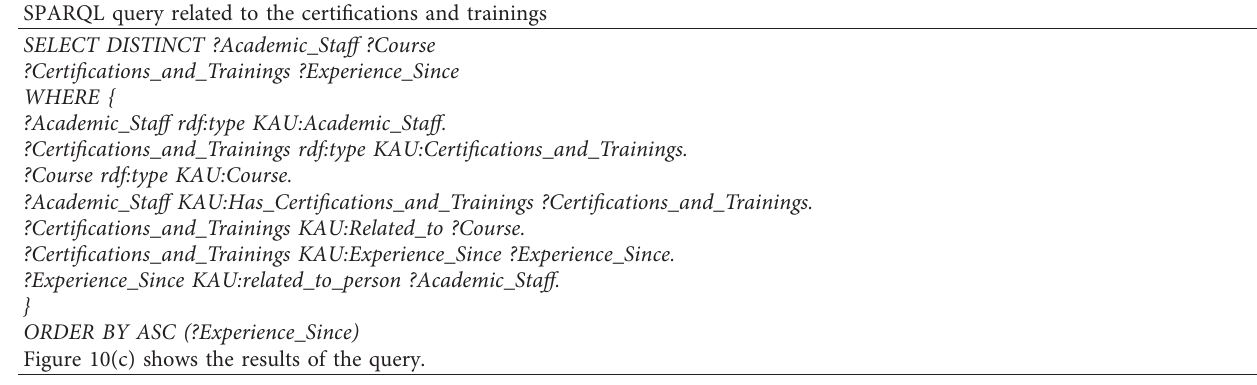
Table 11: The certifications and trainings example after criteria.